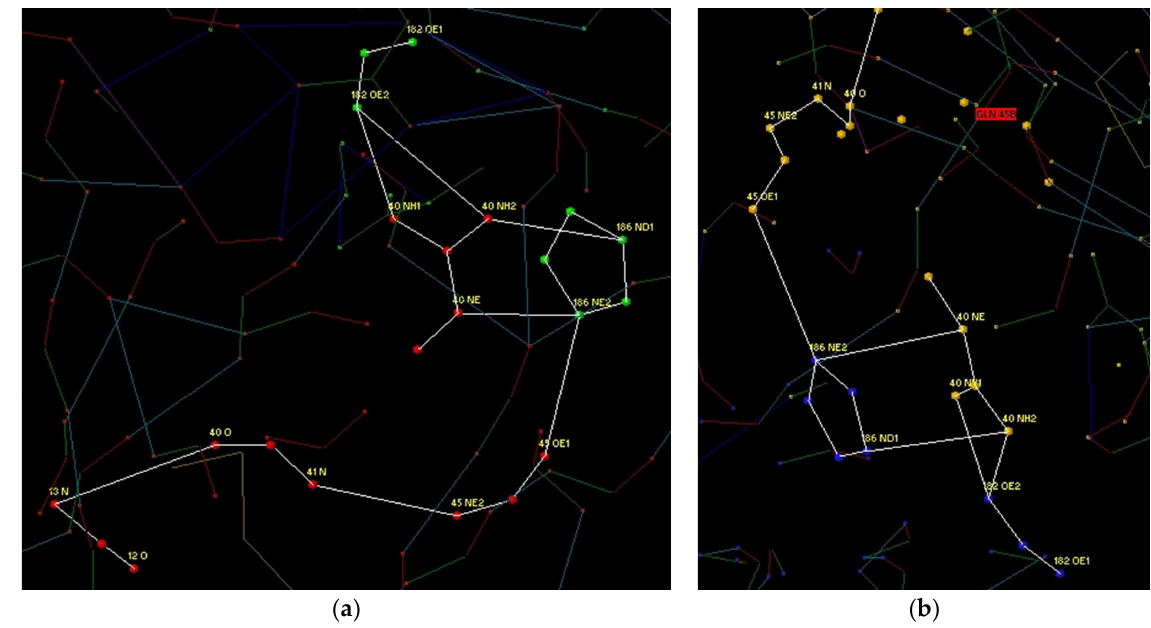
Figure 4. Comparative analysis of CIHBS in complex between А (red) and С (green) subunits ( а ), complex between B (yellow) and D (blue) subunits ( b ).